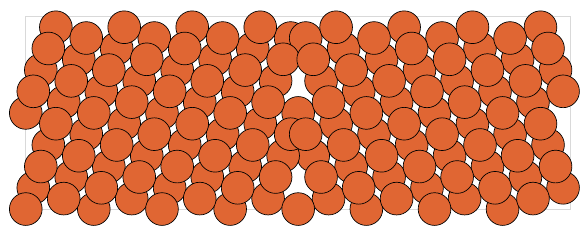
Fig. 10 Atomistic GB structure. The structure of the Σ 9 f 122 g½ 110 (cid:5) symmetric tilt GB in α